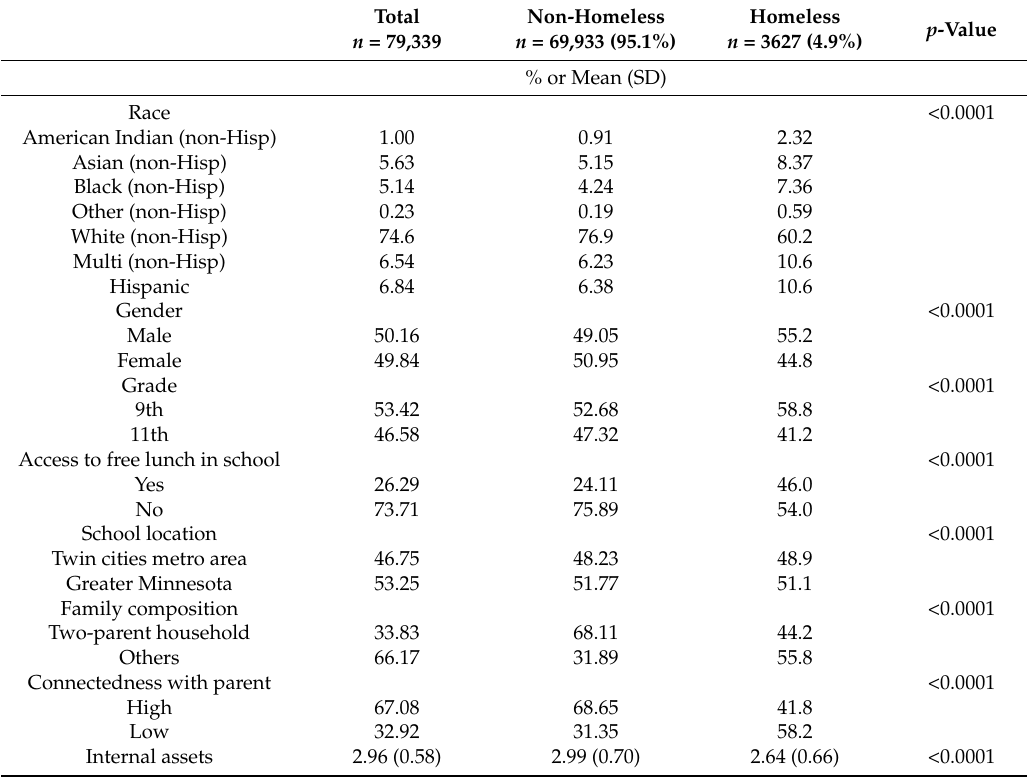
Table 1. Sample characteristics: demographics, family composition, and socio-economic